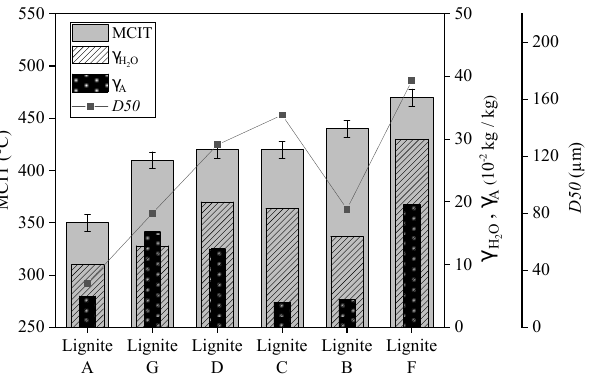
Figure 1. Minimum cloud ignition temperature (MCIT) of lignite qualities in ascending order, left axis: MCIT, first right axis: moisture and ash content, second right axis: median particle